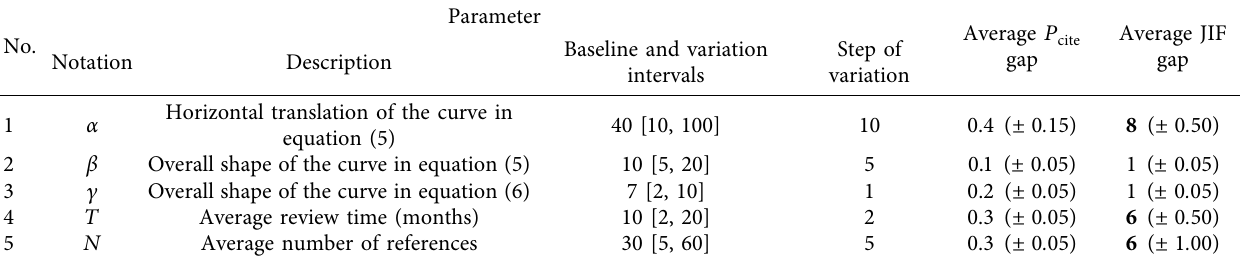
� 2 and N � 60; Figure 12: ( max ) min ) � 30; and Figure 13: T � ( baseline ) ( max )